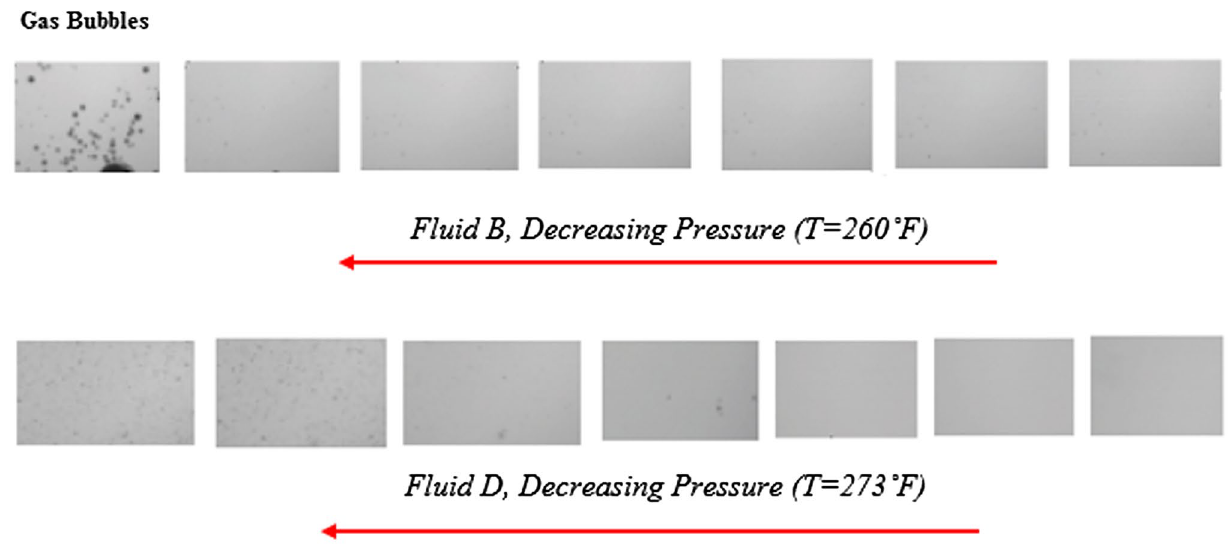
Fig. 11 Results of high-pressure microscopy from Abdallah et al.